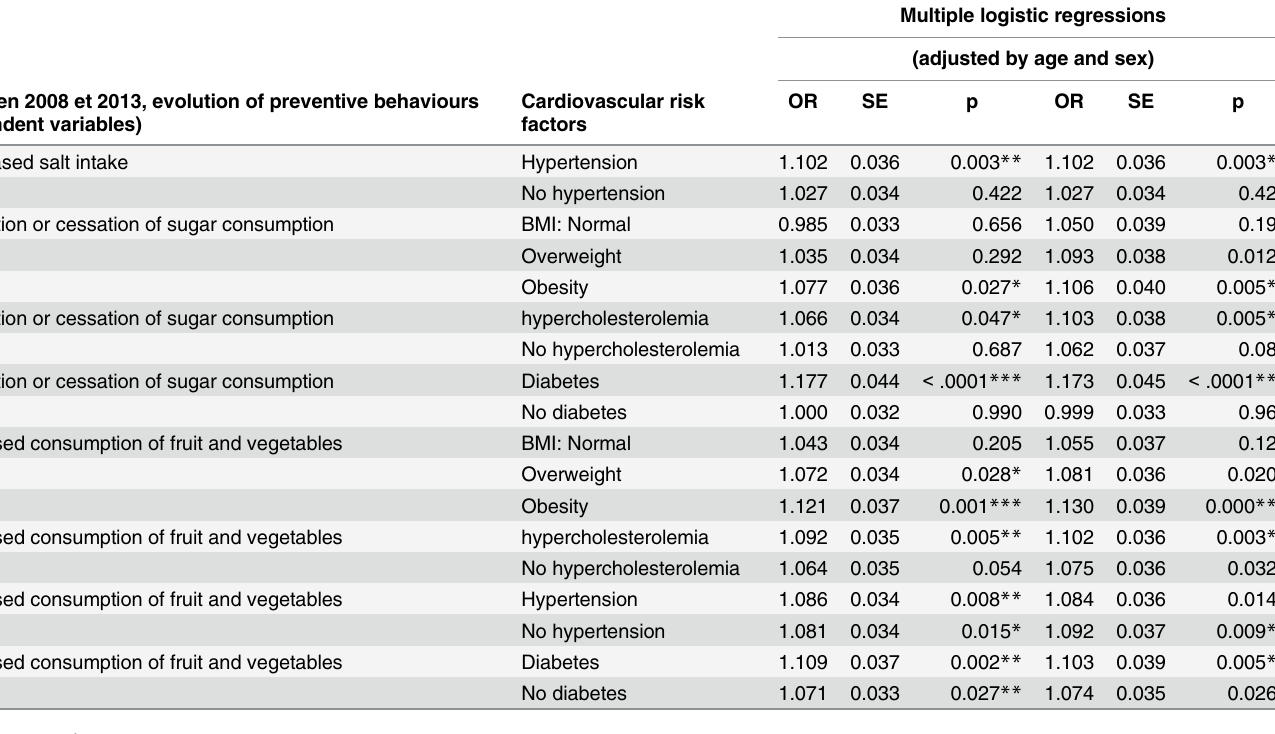
Table 3. Adherence declared of preventive behaviours for each CVRF, and its associations with practitioner-patient communication. Between 2008 et 2013, evolution of preventive behaviours (dependent variables)